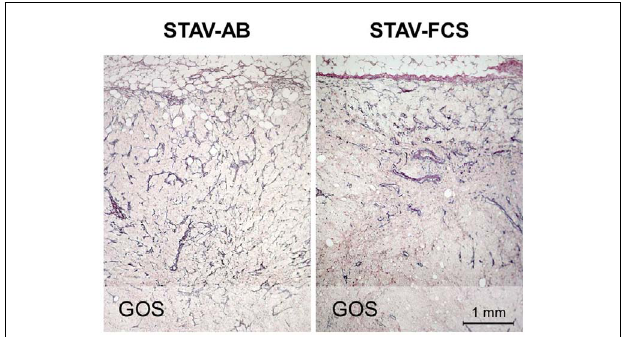
FIGURE 5 | Microvessel density in xenografts demonstrated by staining for reticulin fibers (Gordon and Sweets) . Xenografts from STAV-AB cells showed uniform vascularization, whereas xenografts from STAV-FCS cells showed decreased vascularization at a depth of 0.5–1mm into the tumor.The tumor invasion front is seen at the top in both images.